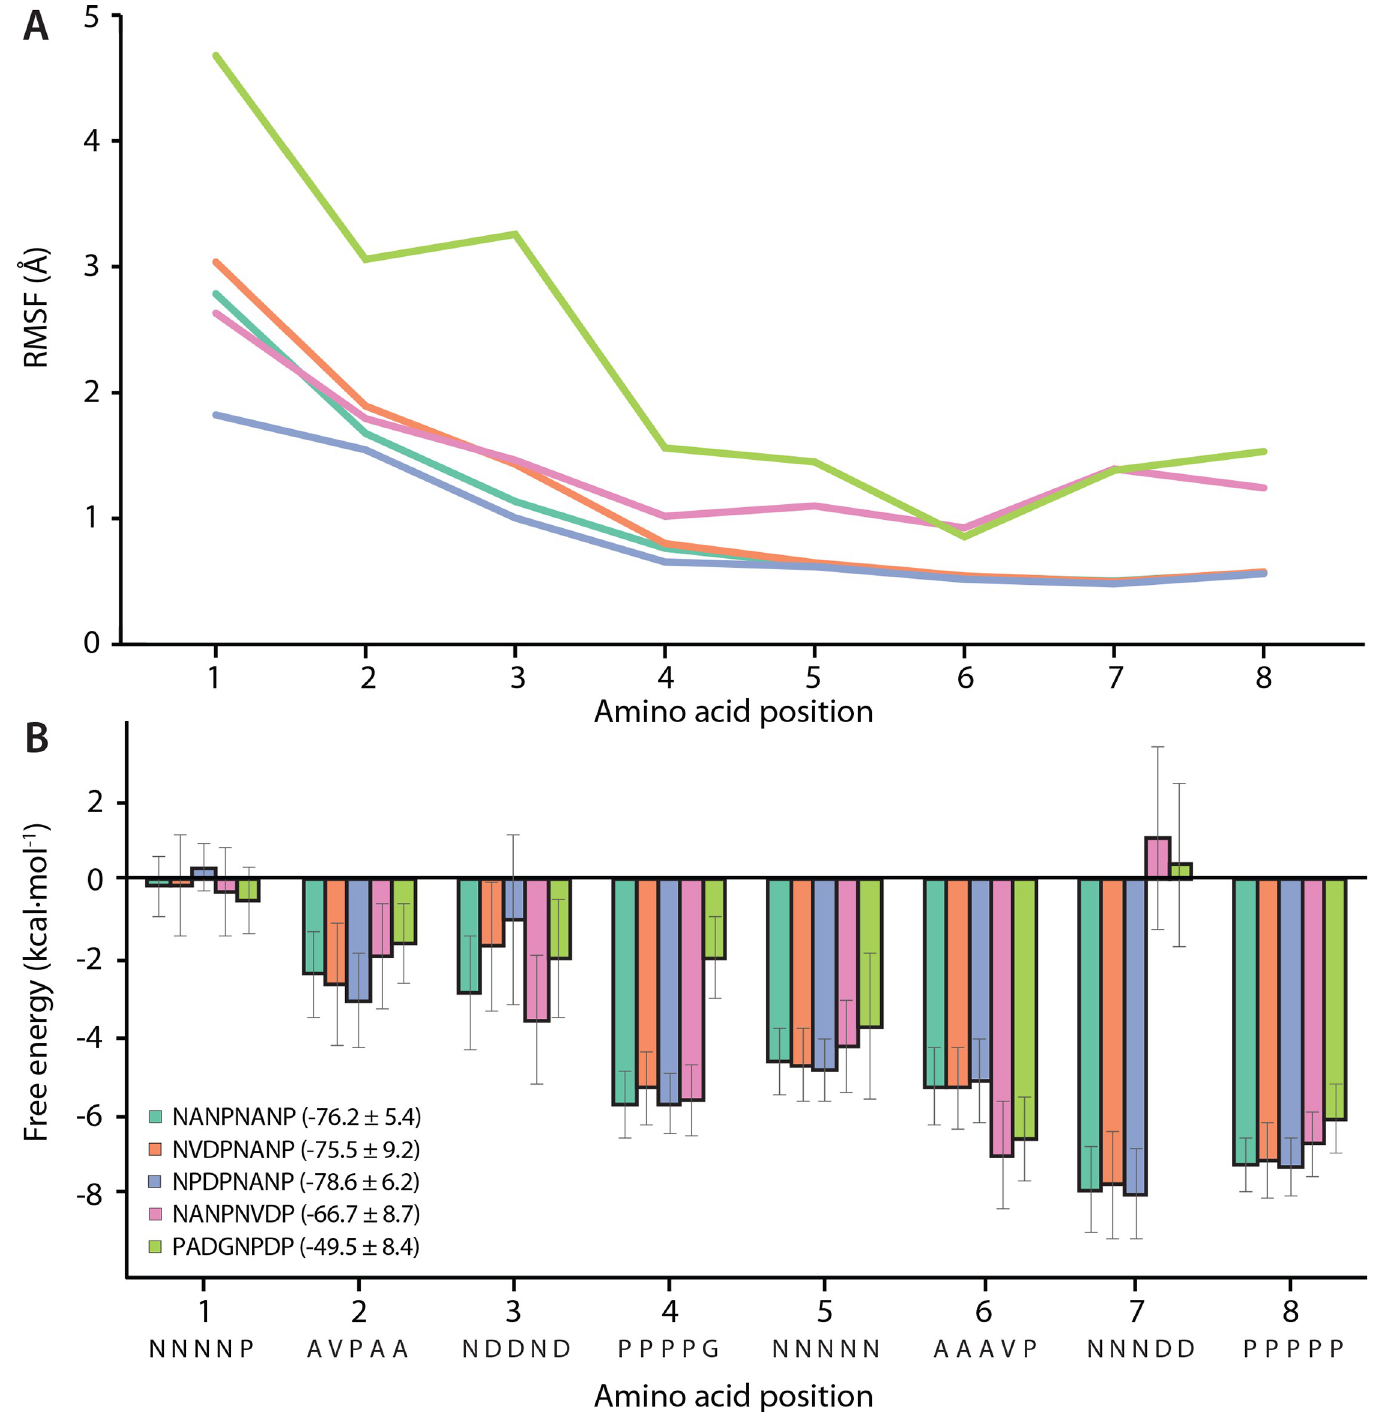
Fig 3. Molecular dynamics simulations to dissect the mechanism of Fab668 binding. Molecular dynamics (MD) simulations were undertaken to dissect binding to a variety of possible repeat epitopes for Fab668. (A ) Root mean square fluctuations (RMSF) from 1.2 μ s aggregate runs were calculated for each of the modeled peptide- Fab668 structures and plotted (NANPNANP: green, NVDPNANP: orange, NPDPNANP: blue, NANPNVDP: pink and PADGNPDP: lime, see also the graph legend in B ). ( B ) Using the molecular mechanics / generalized Born solvent accessibility (MM/GBSA) approach, free energy contributions were calculated for each peptide and plotted as a function of amino-acid position (color code as in panel A